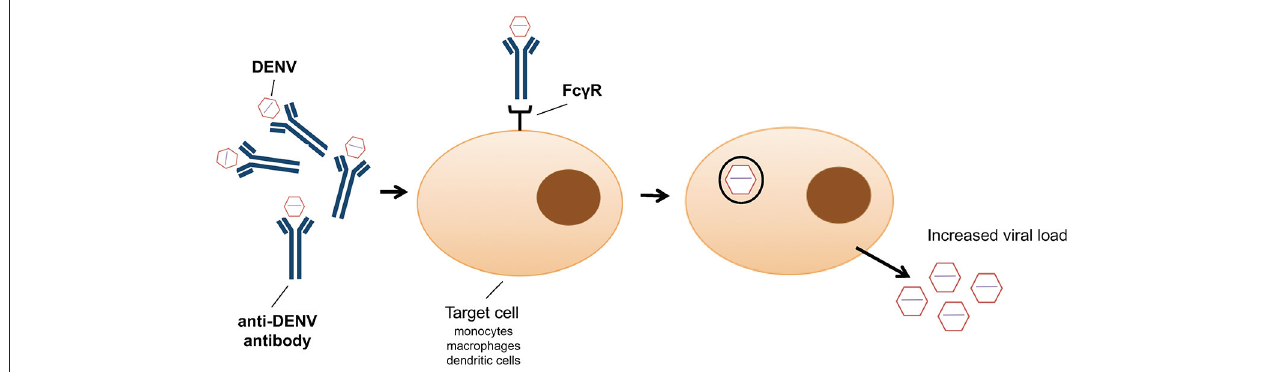
FIGURE 1 | Schematic representation of antibody dependent enhancement (ADE) entry into monocytes, macrophages and dendritic cells as employed by dengue virus.